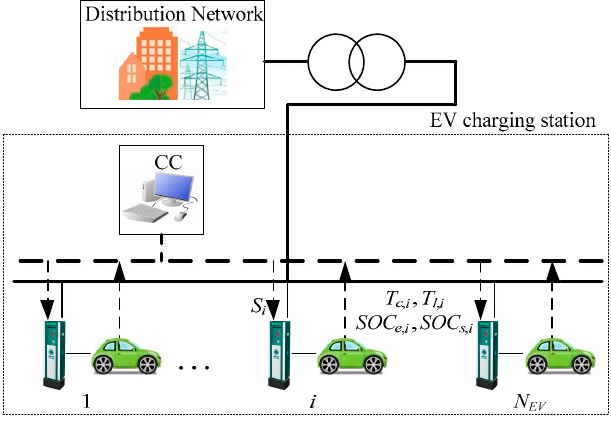
Figure 3. Centralized control architecture.